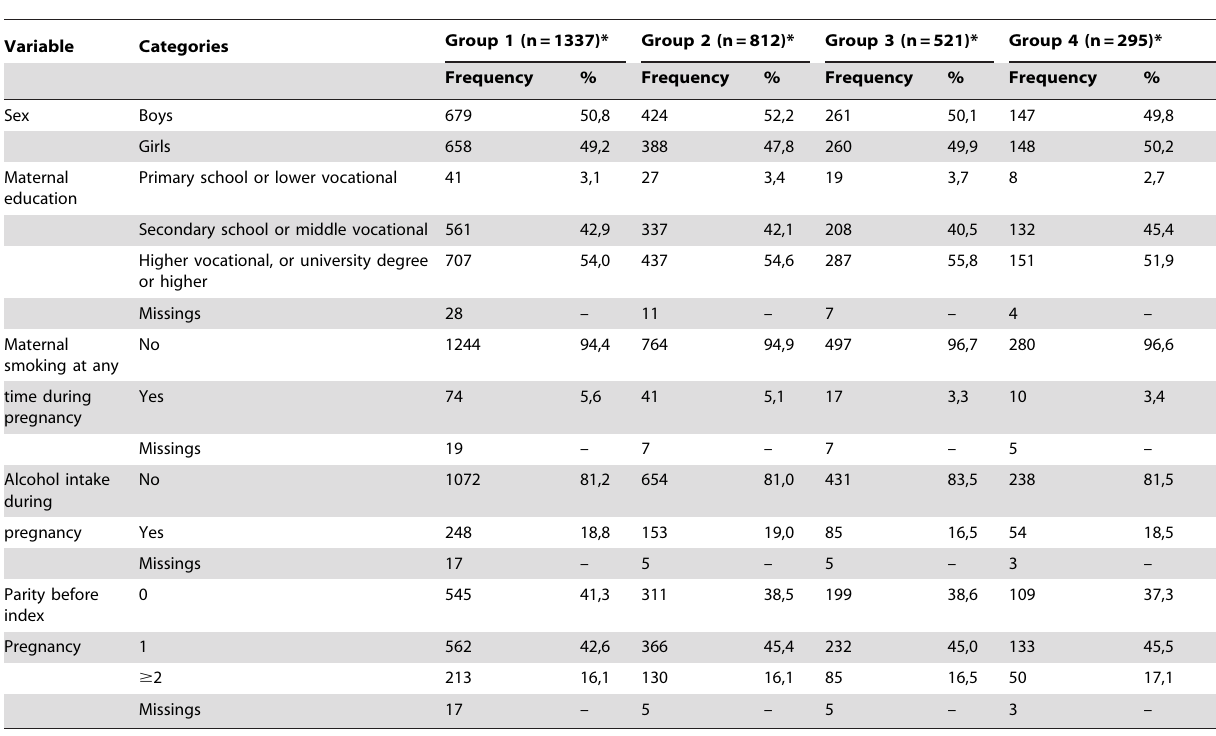
equilibrium. According to the regression coefficients obtained in model 1 ( table 6 ), heterozygous children ( Mm ) for the SNP SNPs characteristics and genotype and minor allele frequencies are shown in table 5 . All SNPs were in Hardy Weinberg Table 4. Representativeness of the study participants regarding categorical